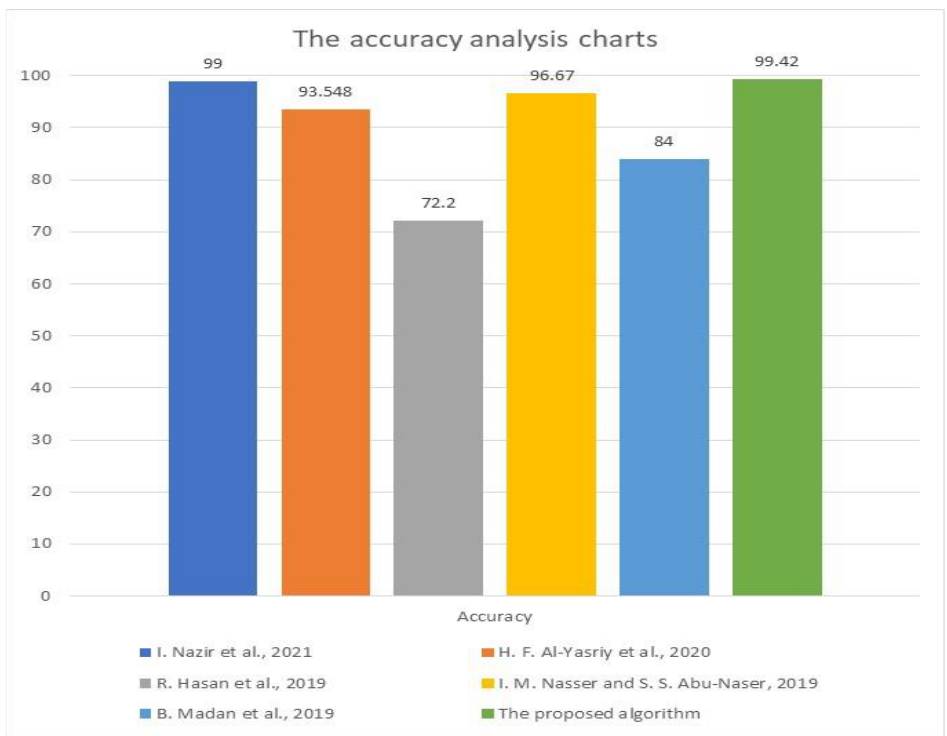
Figure 12. The comparative accuracy analysis charts between the proposed approach and some works [3,5,7,9,16].